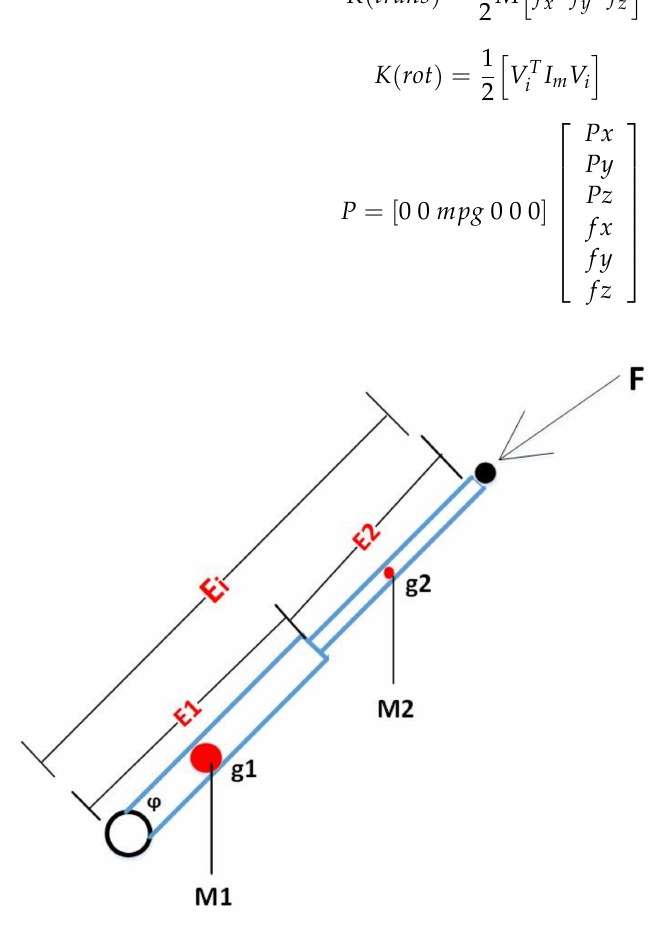
energies comprise the total kinetic energy of the machining bed. For the moving top plate of the machining bed, the translational and rotational kinetic energies are given as in Equations (9) and (10), where f x , f y and f z are the positions in the x, y, and z axes, respectively. Potential energy for the movable top plate is given by Equation (11).